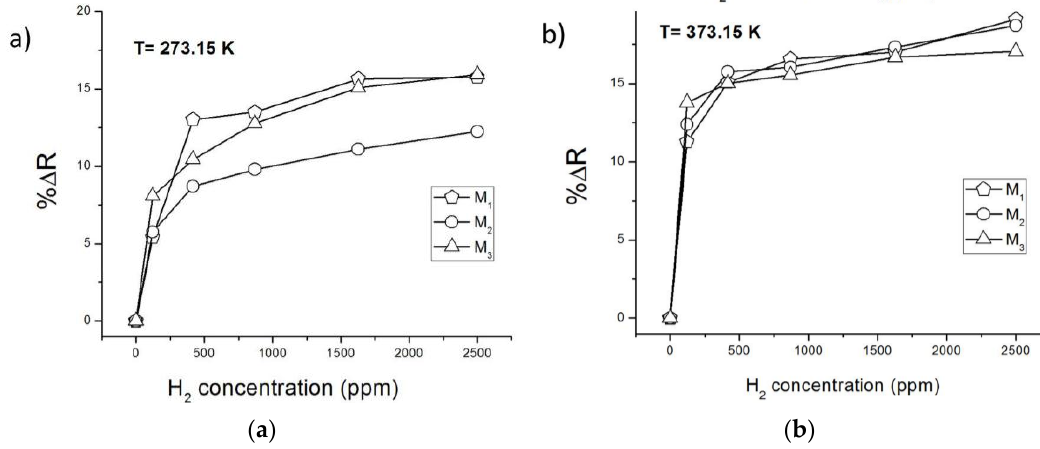
Figure 4. ZnO nanowire gas sensor devices percentage resistance changes for different H 2 concentrations pulses. ( a ) At room temperature; ( b ) at 373.15